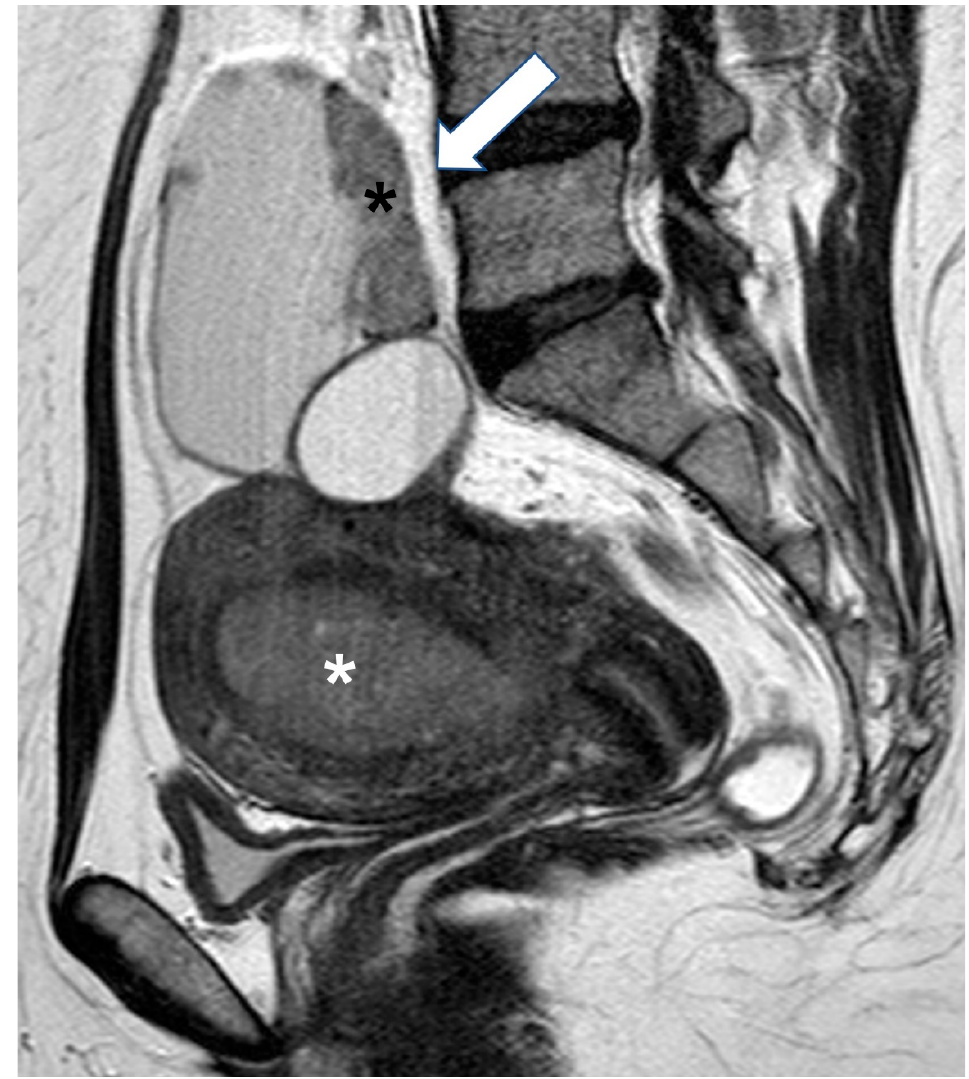
Figure 8. Synchronous ovarian and endometrial endometrioid adenocarcinoma. Sagittal T2 weighted image shows a soft-tissue mass occupying the endometrial cavity (white asterisk). Note a solid and cystic mass of the right ovary (arrow) with the solid component (black asterisk) exhibiting similar signal intensity to that of the endometrial mass.